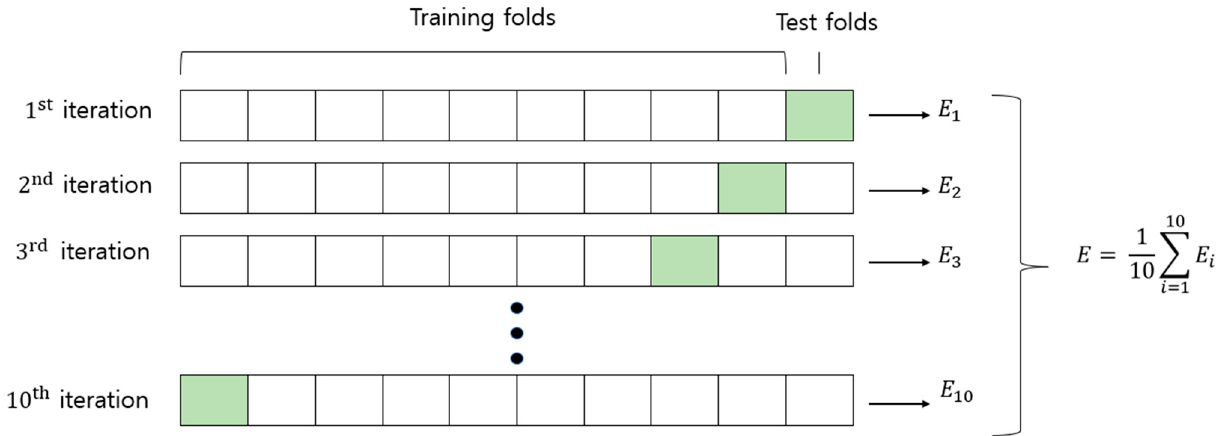
Figure 2. Ten-fold cross-validation contributing to the accuracy and error in this study.